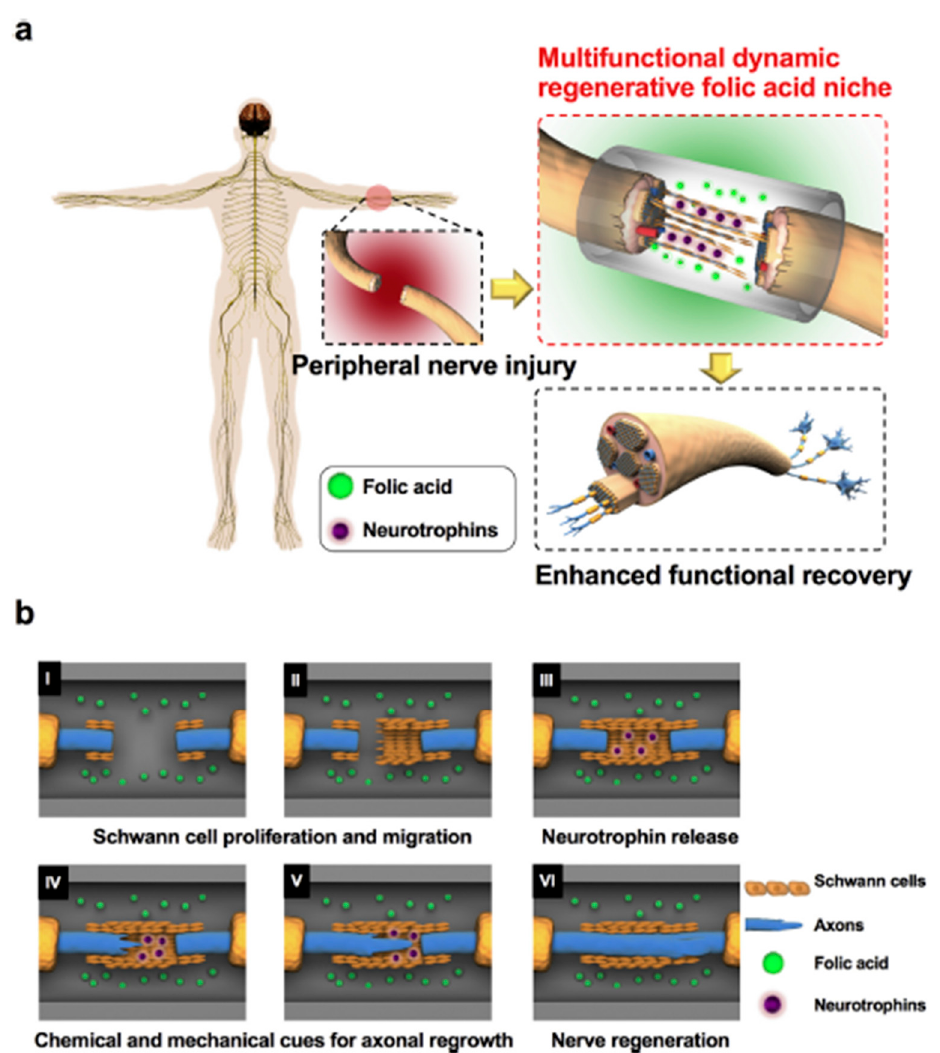
Figure 4. Nerve guidance conduits for the local release of folic acid in order to promote nerve regeneration. ( a ) Overview of the folic acid niche that provides chemical and mechanical cues to enhance functional recovery in a peripheral injury model. ( b ) Cartoon illustrating the detailed mechanism of the multifunctional and dynamic neuroregenerative folic acid niche and how it allows peripheral nerve regeneration by modulating the proliferation and migration of Schwann cells ( I , II ), stimulating the Schwann cells to release more neurotrophins ( III ), and increasing mechanical forces in the neurons that in turn boost the axonal regeneration of the neurons ( IV , V ) and peripheral nerve regeneration ( VI ). This figure is reproduced from [33] with permission from Elsevier Ltd.